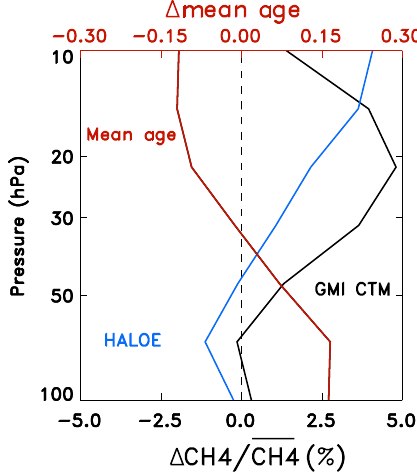
Figure 15. Percentage differences between 1994–1999 and 2000– 2005 winter mean CH 4 profiles at 35–55 ◦ S for HALOE (blue) and GMI CTM (black). The difference between the 35–55 ◦ S winter mean age profiles for the same periods is shown in